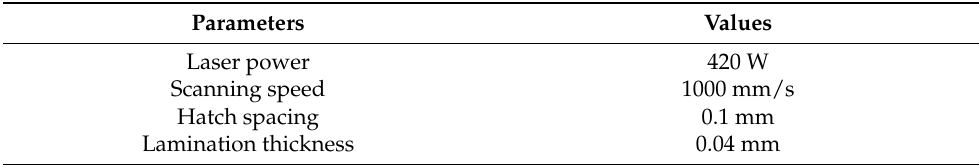
Table 2. Parameters used for the selective laser melting of 18Ni-300 maraging steel.